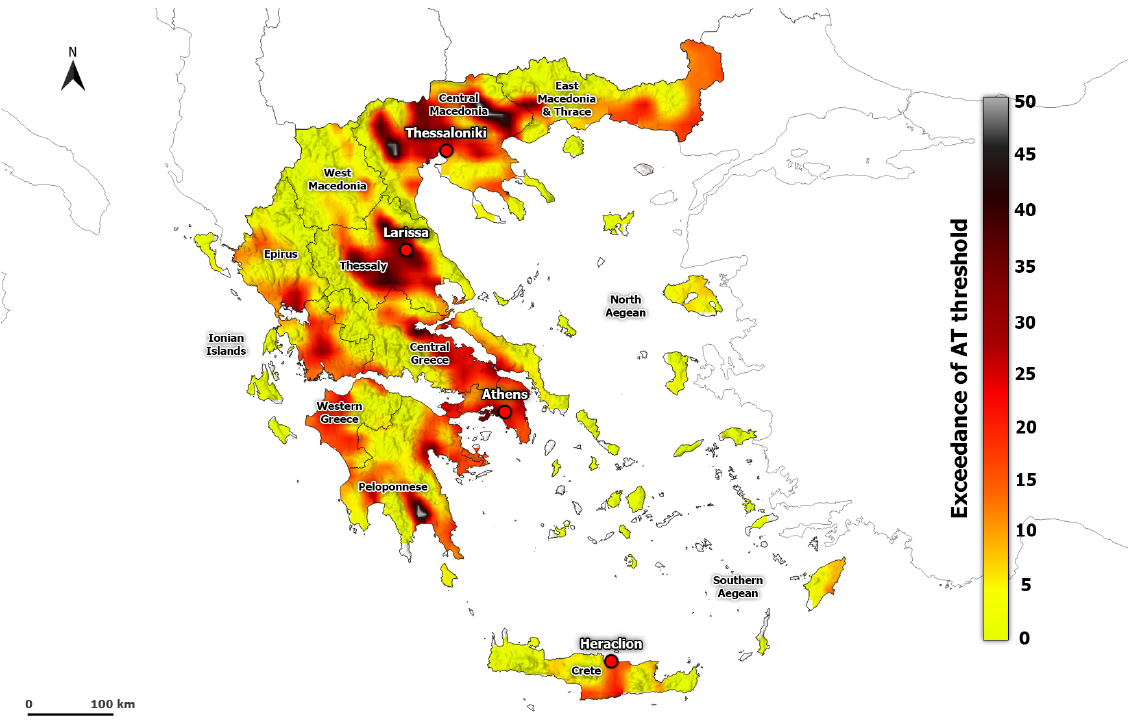
Figure 5. Spatial distribution of averaged AT41C (days) based on all heatwave events calculated from ERA5-Land during the period 1950–2020. ERA5-Land during the period